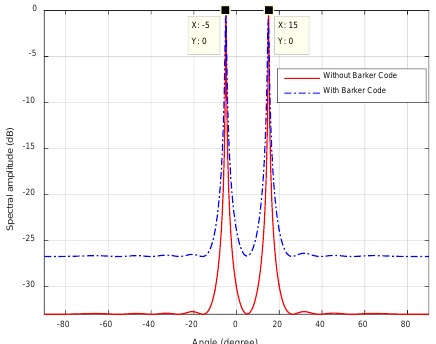
Figure 13. DOA estimation spatial spectrum using spatial smoothing technique in transform domain.